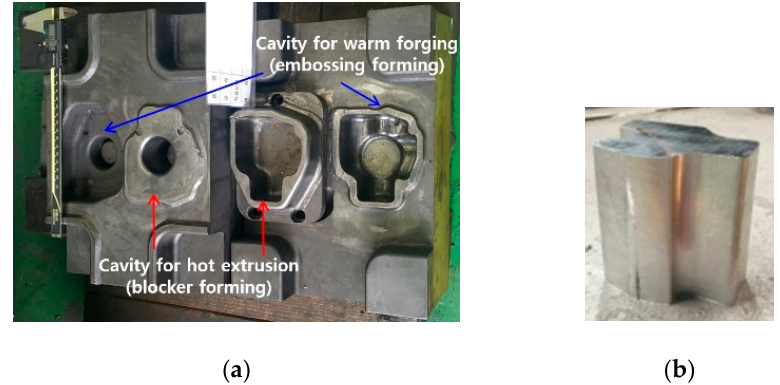
Figure 14. Tool and material for experiment. ( a ) Die of hot extrusion and warm forging. ( b ) Initial specimen.